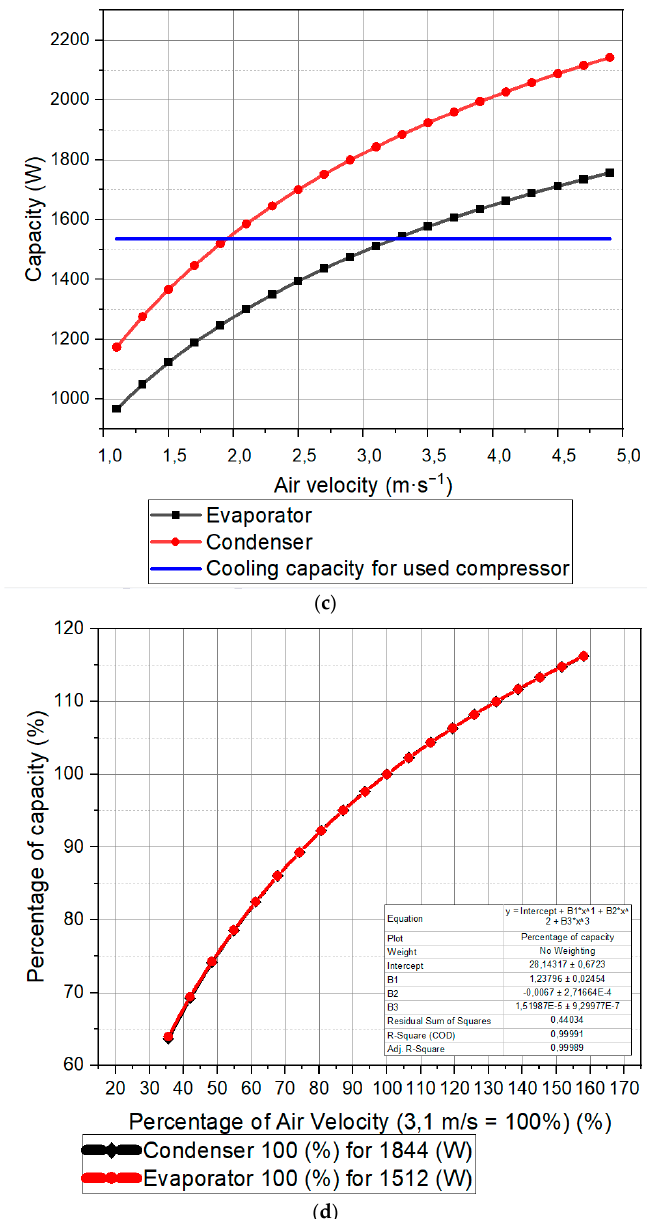
Figure 8. Calculation results for different air flow velocities. The other two charts concern the change in the heat transfer coefficient ( 𝛼 (cid:3043) ) “a” and the heat transfer coefficient (exchanger wall) ( 𝑘 (cid:3002) ) “b”. When air flow velocity increases, the cooling capacity of the heat exchangers also rises. Based on polynomial regression of the third order, the equation of the curve in the “d” chart on Figure 8 is